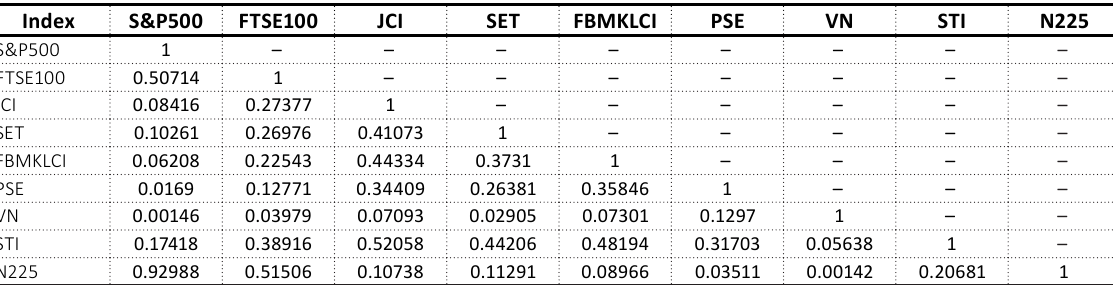
Table 6. Conditional correlation generalized autoregressive conditional heteroskedasticity (CCC-GARCH(1,1)) estimates